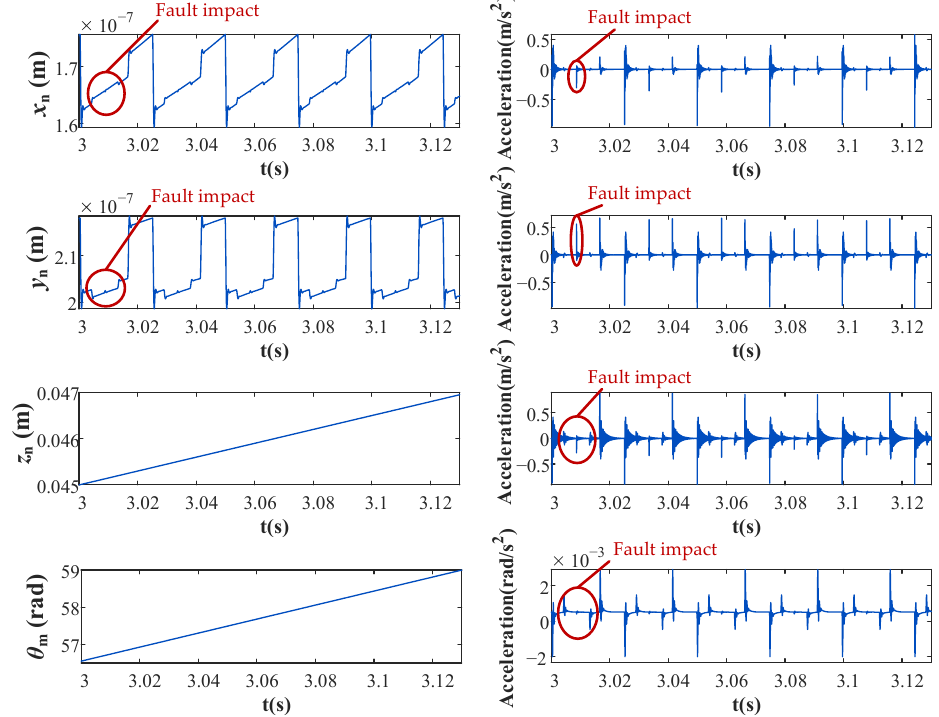
Figure 11. Displacement responses and acceleration responses of the nut or motor output shaft-related parameters under faulty conditions.